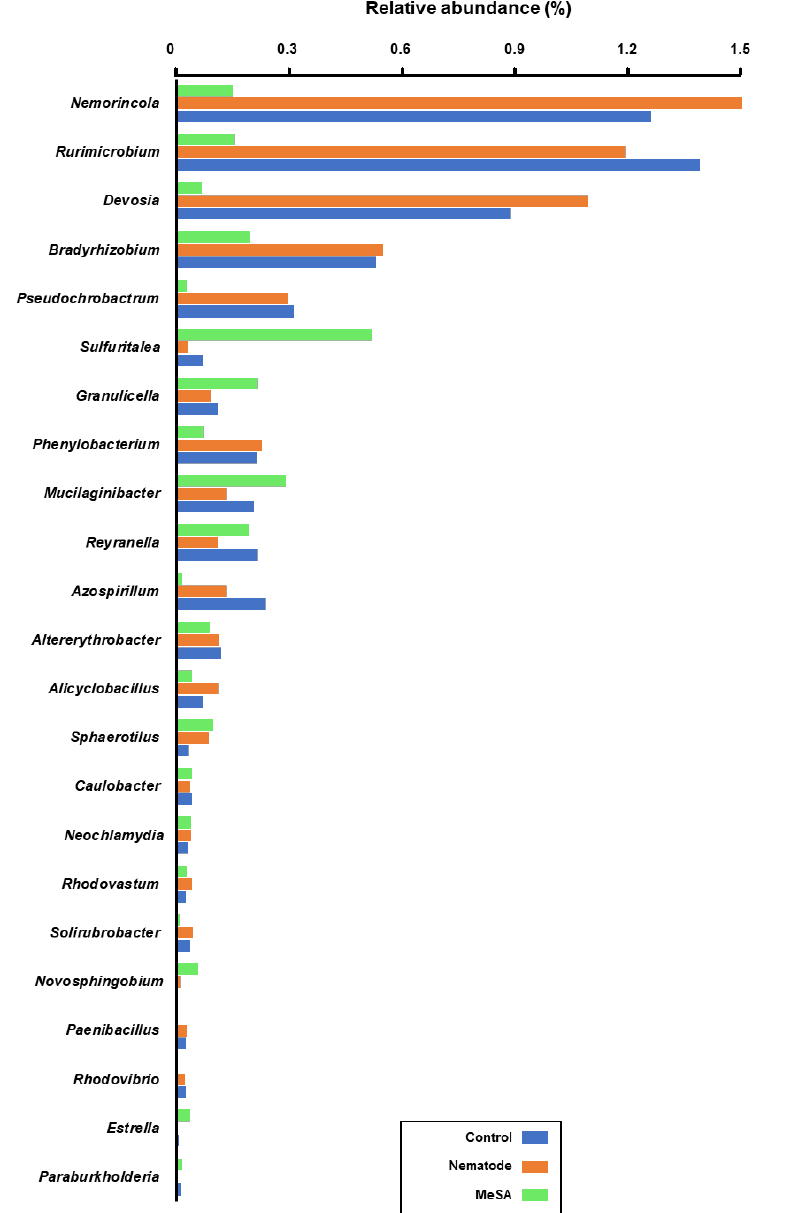
Figure 3. Stacked bar graphs representing the structure of pine rhizosphere microbiota at the phylum ( A ) and class ( B ) levels. Samples were treated with methyl salicylic acid (MeSA) or acibenzolar-s- methyl (ASM), followed by inoculation with the nematode, and compared to nematode-treated and control samples.